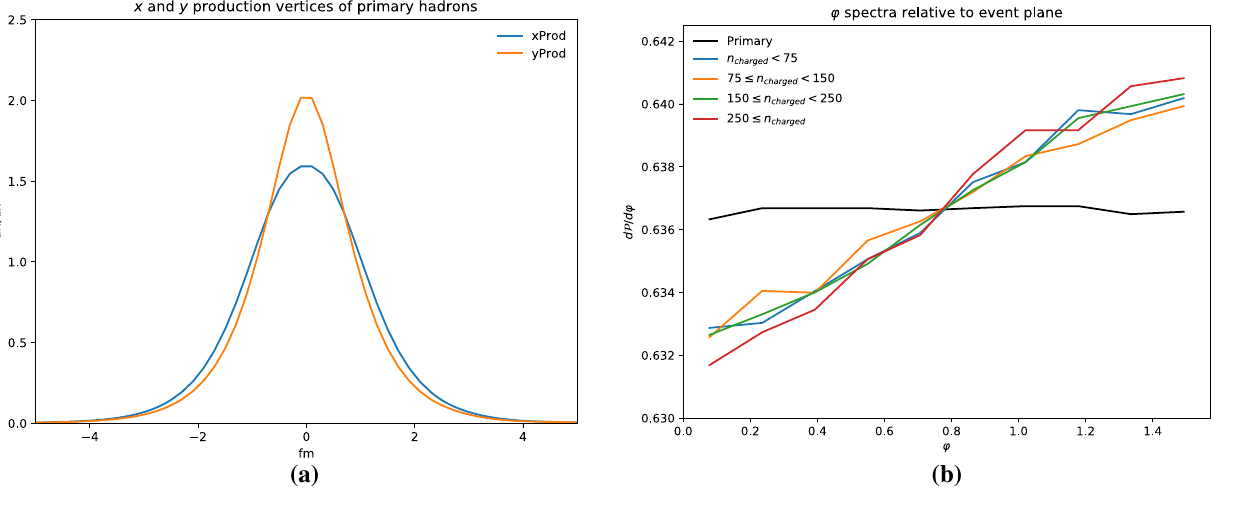
Fig. 10 a x and y coordinates of primary hadrons, showing an initial anisotropy. b Azimuthal direction of momentum for outgoing hadrons, binned according to charged multiplicity. The angle is the acute angle